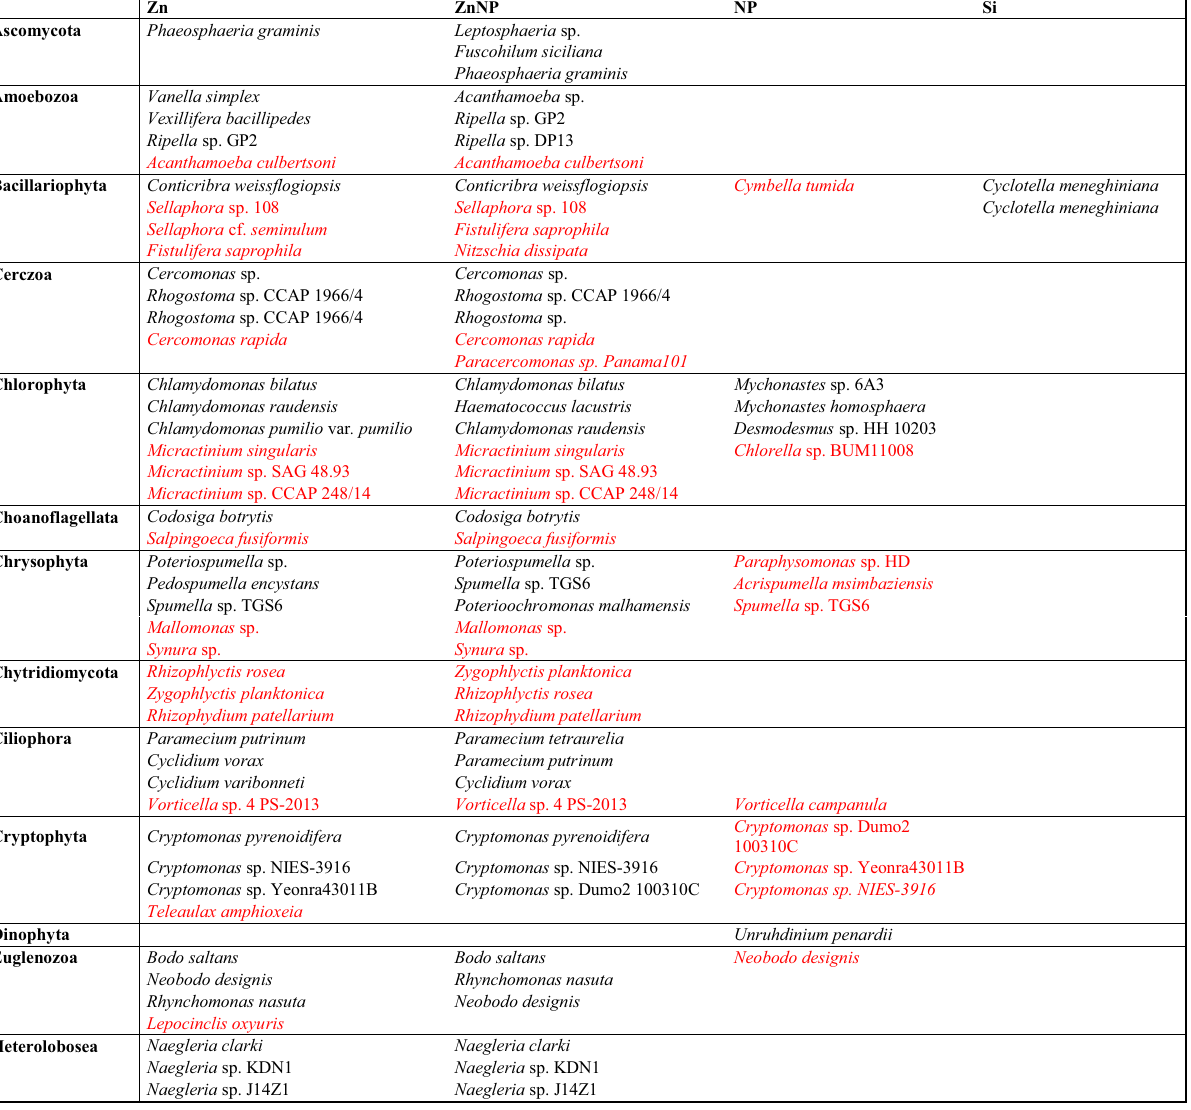
Table 1. Showing the top 3 increased (black) and top 3 decreased (red) differential abundant OTUs for individual groups and